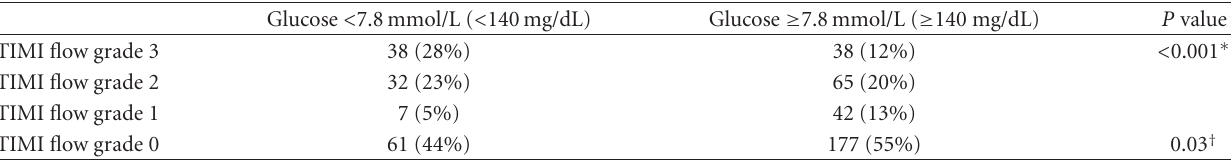
Table 1: Initial TIMI flow grade according to admission glucose. Worse initial Thrombolysis in Myocardial Infarction (TIMI) flow grade is demonstrated in those with hyperglycemia.